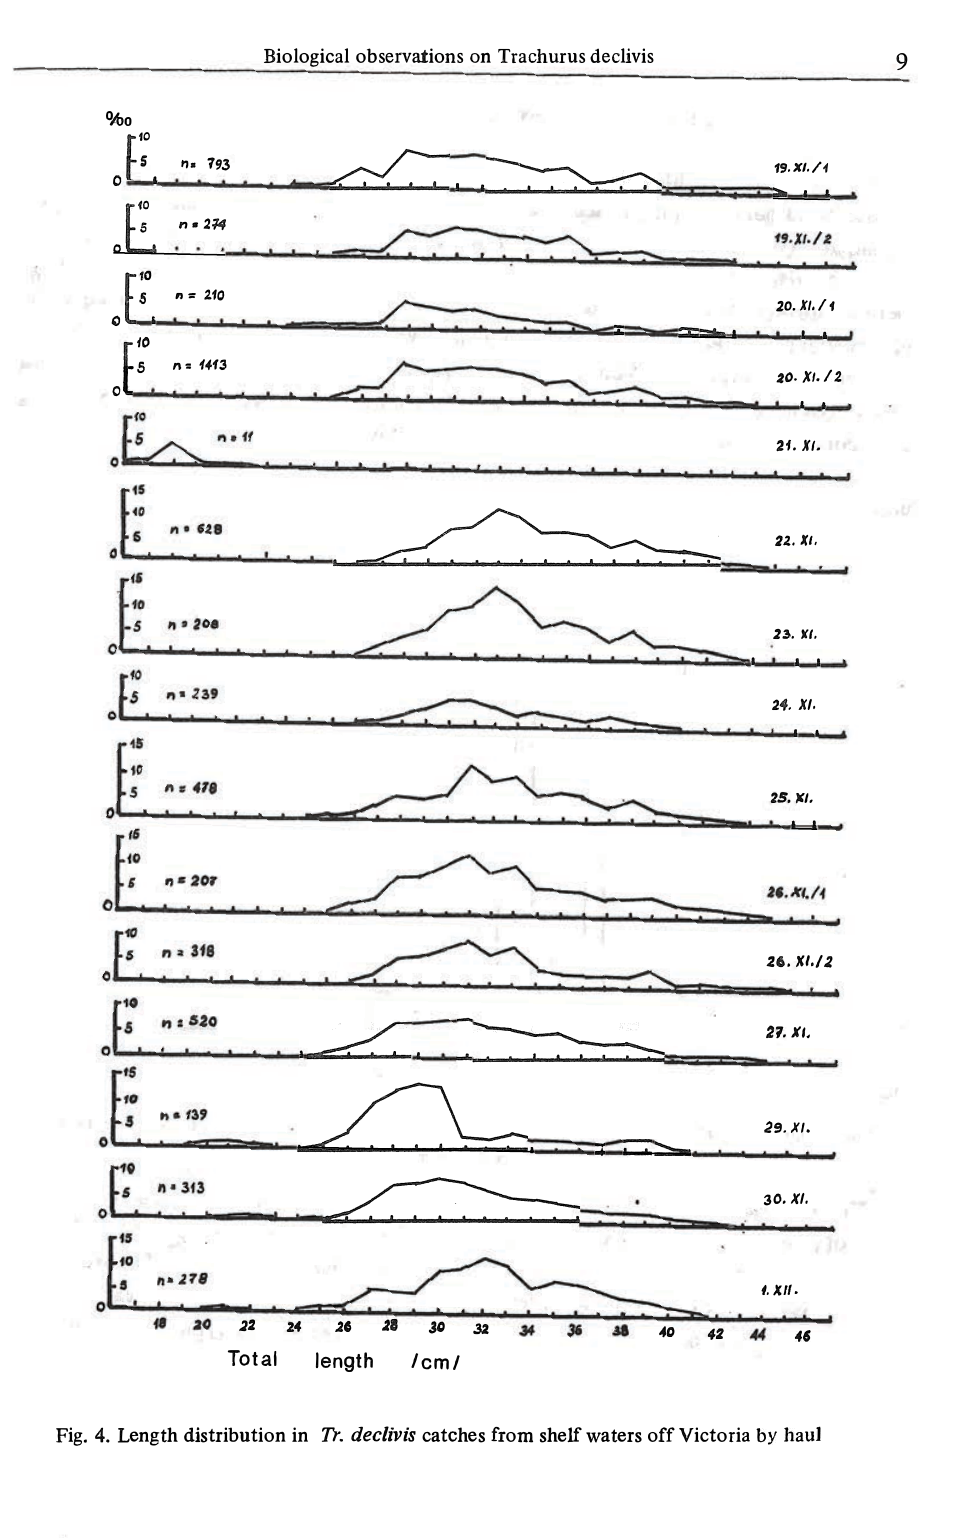
Fig. 4, Length distribution in Tr. declivis catches from shelf waters off Victoria by